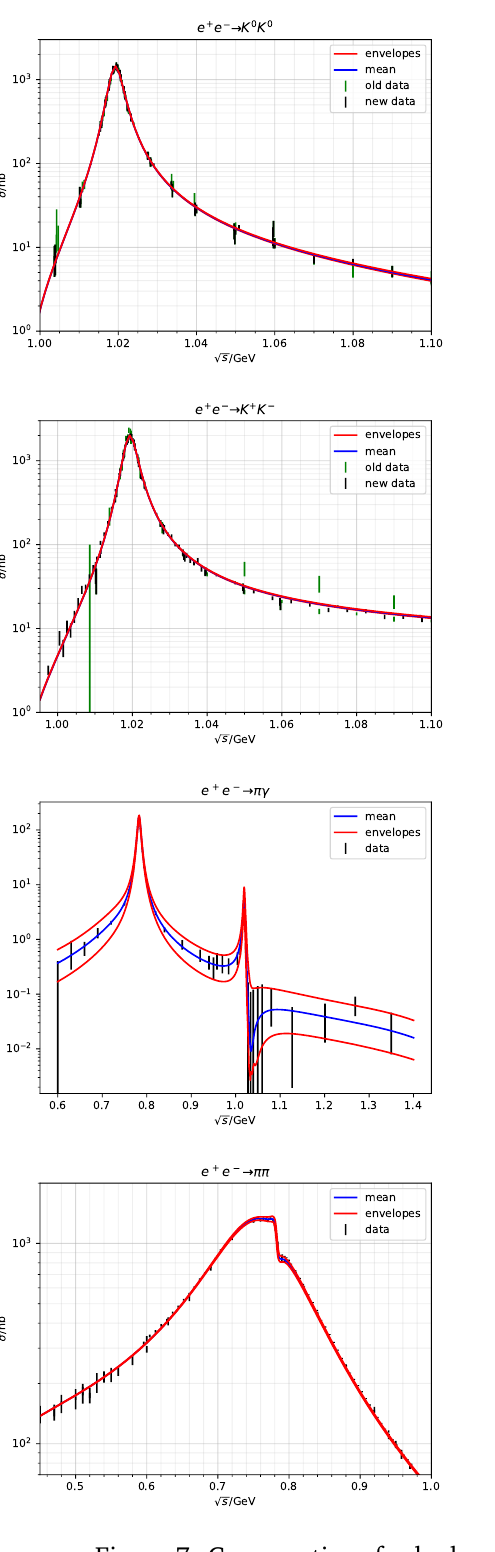
Figure 7: Cross sections for hadronic final states with error